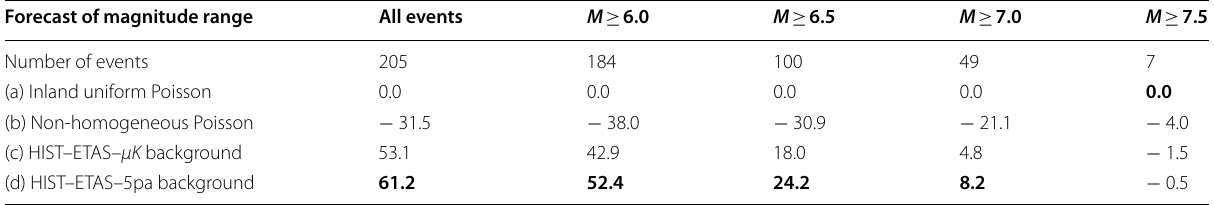
Scores are the same as explained in Table 2